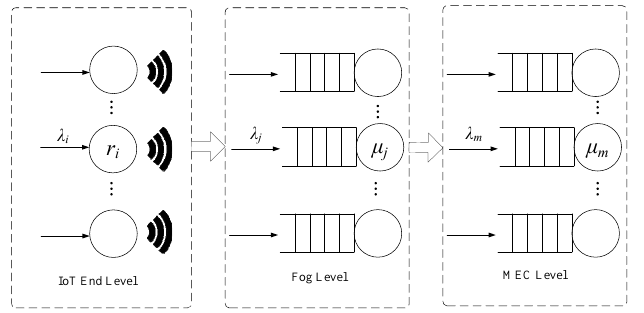
Figure 2. The tandem queue model of IoT-Fog-Edge